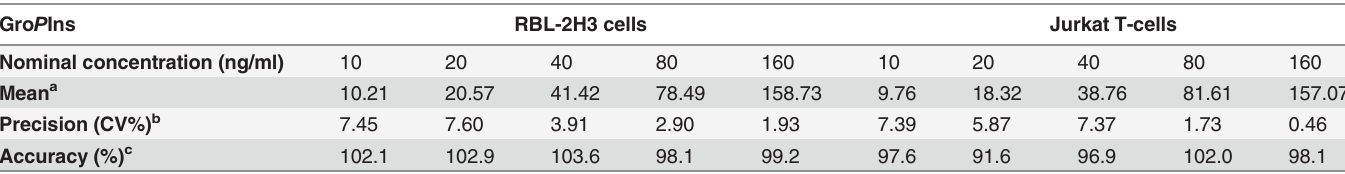
Table 4. Intra-day precision and accuracy in RBL-2H3 and Jurkat T-cell extracts. Gro P Ins RBL-2H3 cells Jurkat T-cells Nominal concentration (ng/ml) Mean